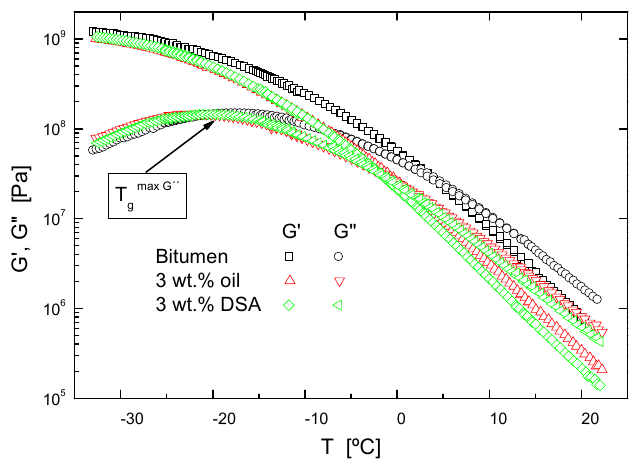
Figure 2. Evolution of the storage and loss moduli, from temperature sweep tests in oscillatory shear, at 10 rad/s, for neat bitumen and unaged modified bitumen, at low temperatures. Table 4. Parameters C1 and C2 of WLF equation and “mechanical” glass transition tempe- rature, T gmax(G (cid:48)(cid:48) )